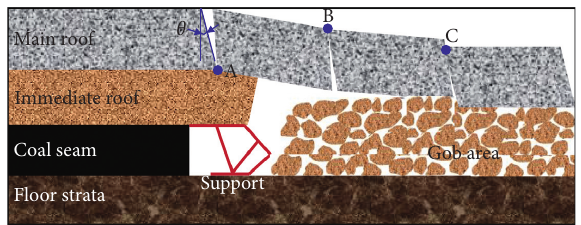
Figure 13: The voussoir beam